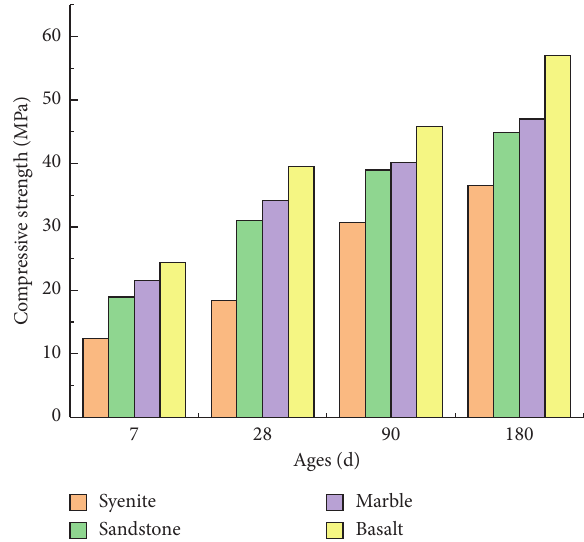
Figure 1: The results of four aggregates on compressive strength of